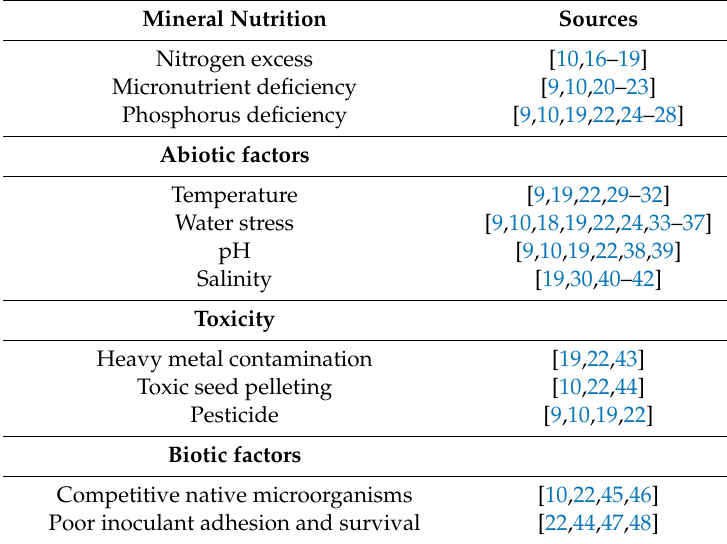
Table 1. Barriers to rhizobial